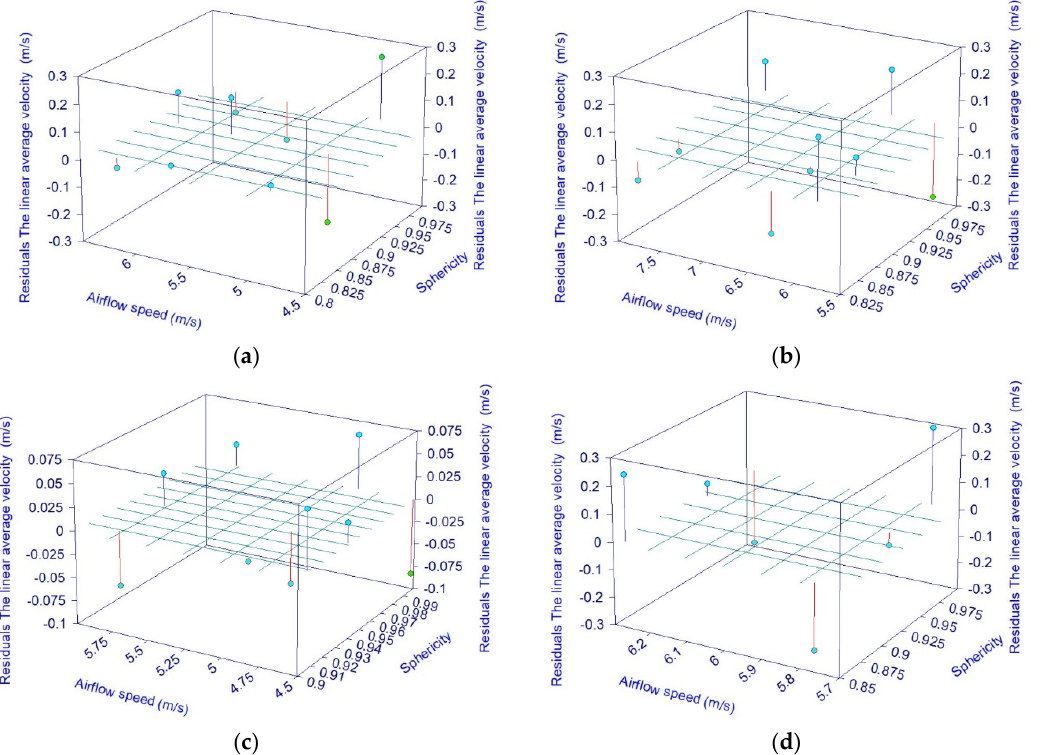
Figure 12. The residual graphs corresponding to the average instantaneous velocity [44]: ( a ) a particle measuring 27 mm in diameter; ( b ) a particle measuring 35 mm in diameter; ( c ) a particle measuring 47 mm in diameter; ( d ) a particle measuring 56 mm in diameter.